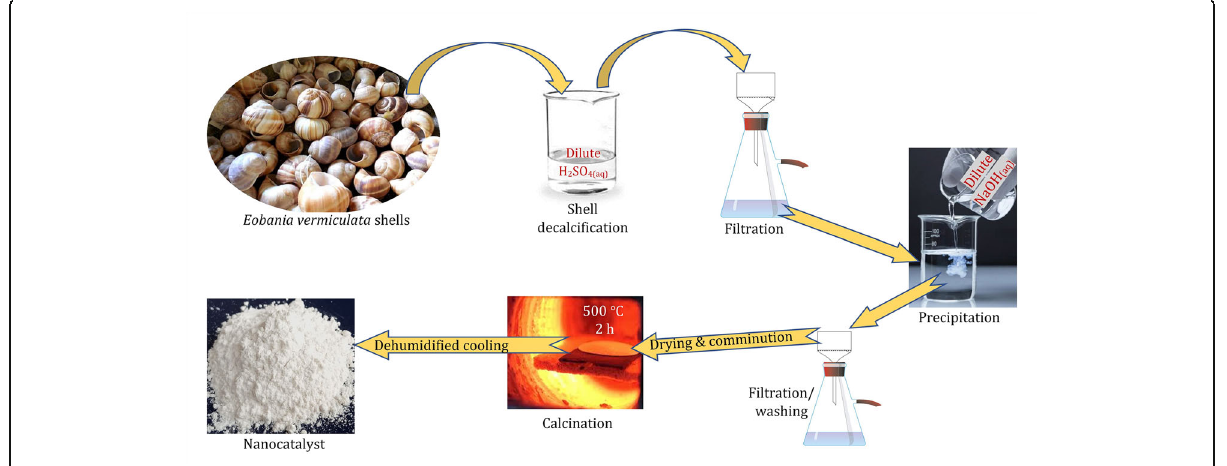
Fig. 3 Schematic demonstration of the shell decalcification-precipitation-calcination route for the nanocatalyst preparation